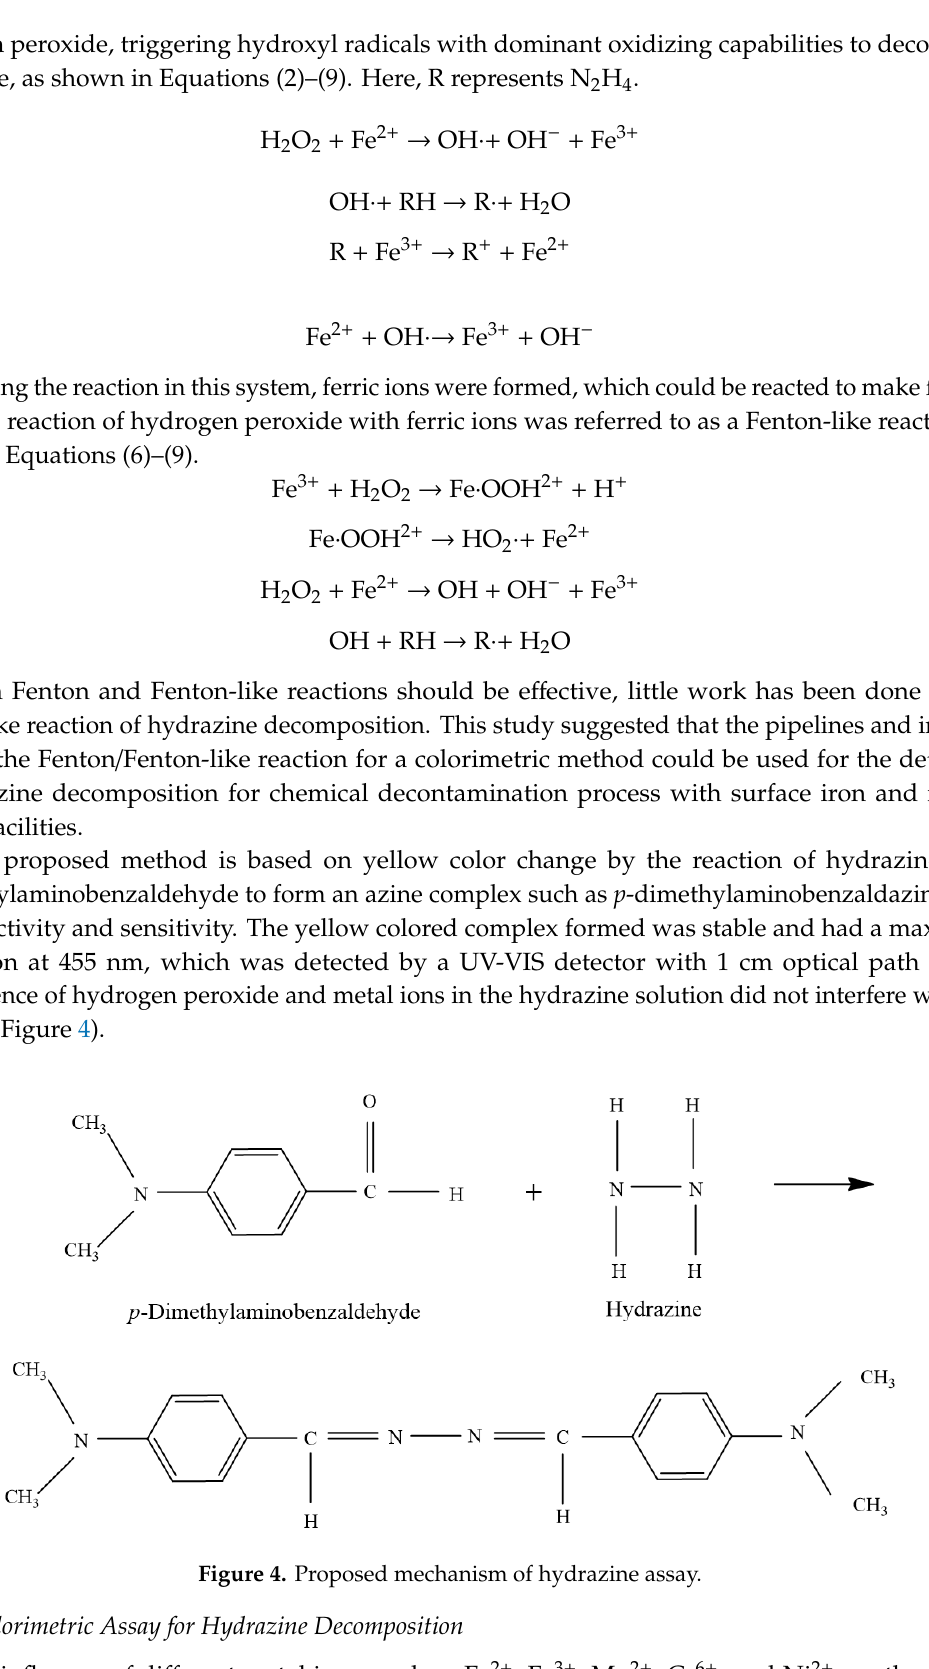
Figure 4. Proposed mechanism of hydrazine assay.